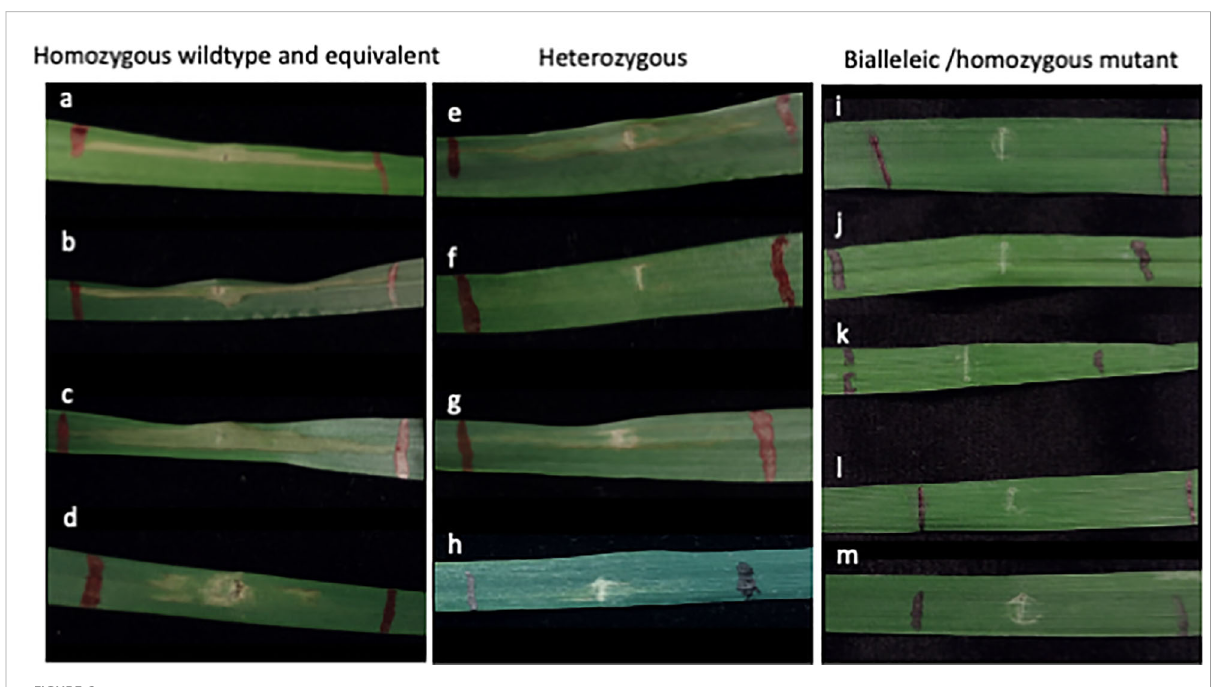
FIGURE 6 SnTox5 assay in Snn5 targeted M 0 regenerants. (A) Fielder control grown from seed. (B – M) Independent M 0 regenerants with (B) homozygous wildtype; (C, D) heterozygous in-frame mutant: (C) -3; (D) -6; (E – H) heterozygous mutant: (E) -5; (F) +20; (G) +2-1; (H) -4; (I – M) biallelic or homozygous mutant: (I) -11, -4; (J) -8, -2; (K) -10, -10; (L) +1, -2; (M) -5, -1 genotypes. Mutation notation is as follows: a positive number, +, indicates the number of bases inserted, a negative number, -, indicates the number of bases